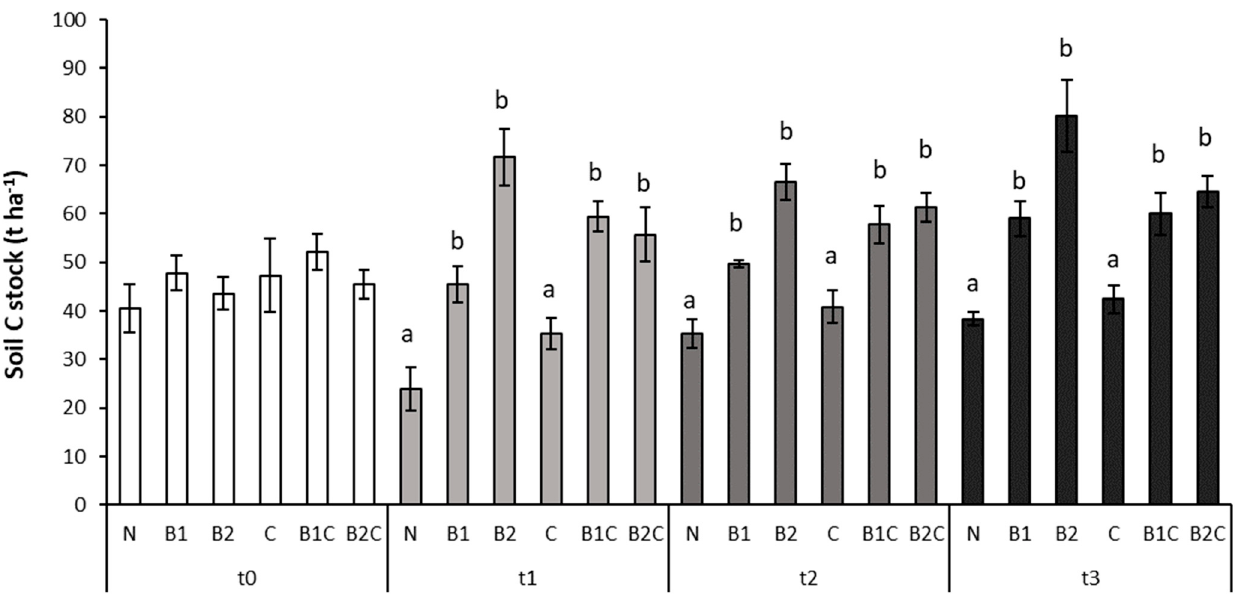
Figure 5. Soil C stock (t ha − 1 ) in the six experimental treatments: N (control), B1 (25 t ha − 1 biochar), B2 (50 t ha − 1 biochar), C (45 t ha − 1 compost), B1C (25 t ha − 1 biochar + 45 t ha − 1 compost), and B2C (50 t ha − 1 biochar + 45 t ha − 1 compost) before the application of soil amendments (t0, white bars), 3 weeks later (t1, light gray bars), 1 year later (t2, dark gray bars) and 2 years later (t3, black bars). Letters above the bars indicate, if different, a statistically significant difference among the six soil treatments within the same sampling time ( p ≤ 0.05). Vertical bars represent the standard error of the mean.